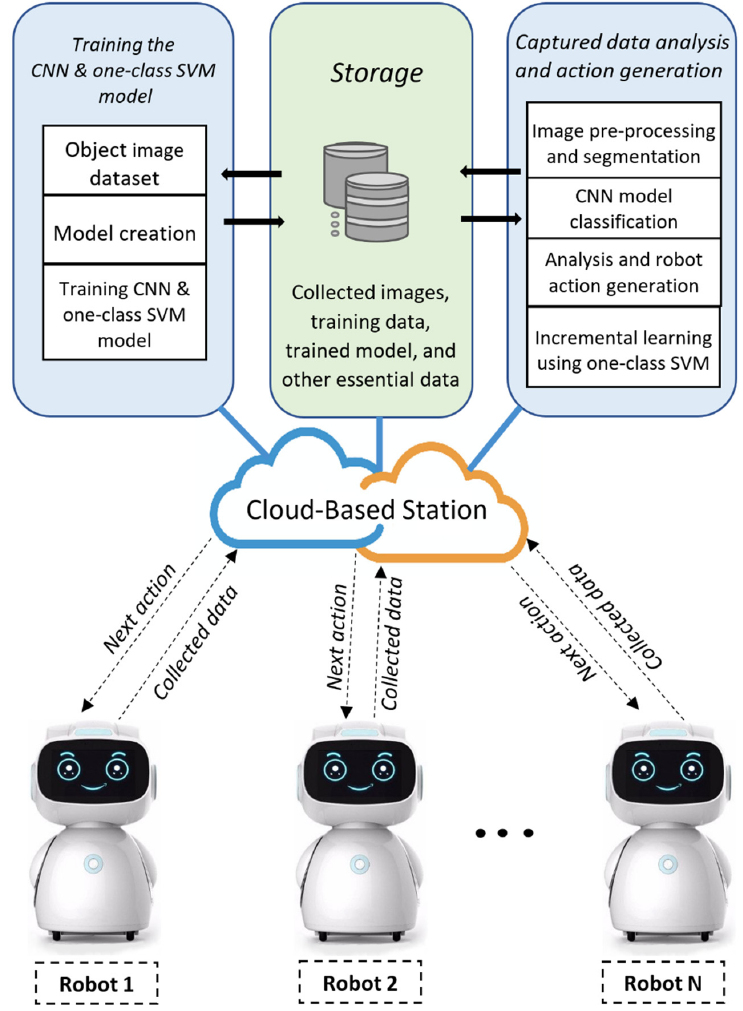
Figure 2. General block diagram of the proposed cloud–robot system.